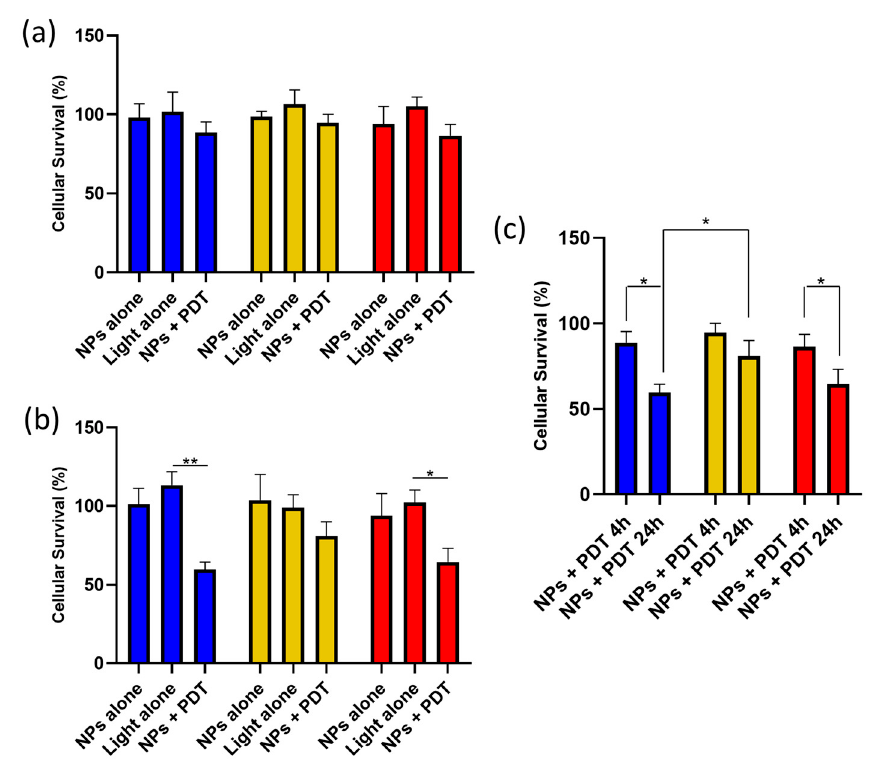
Figure 6. Cell survival on macrophages post-PDT. AGuIX@PS@KDKPPR nanoparticles (NPs, 1 µ M) were incubated with M0, M1, and M2 macrophages for ( a ) 4 h or ( b ) 24 h (group “NPs + PDT”). Several controls were performed, including “NPs alone” and “Light alone”. Cell survival was as-